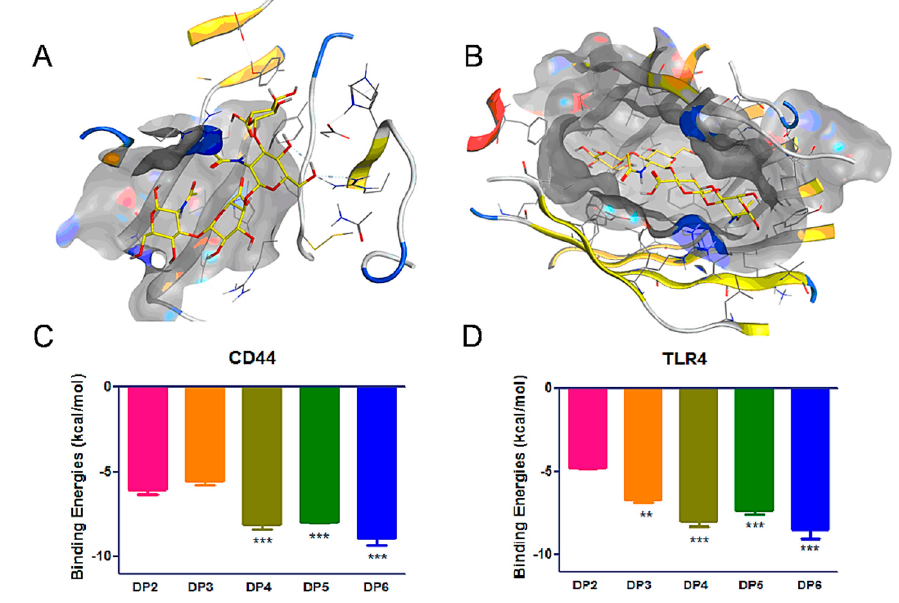
Figure 6. Molecular docking by MOE software of HAOs with receptors. Reasonable binding poses of HA-DP4 in CD44 ( A ) and TLR4 ( B ) pockets. Binding energies of HAOs with CD44 ( C ) and TLR4 ( D ) pockets. Data represent the mean ± SD with reference to the DP2 group, ** p < 0.01, *** p < 0.001; one-way ANOVA with Tukey’s multiple comparisons test.